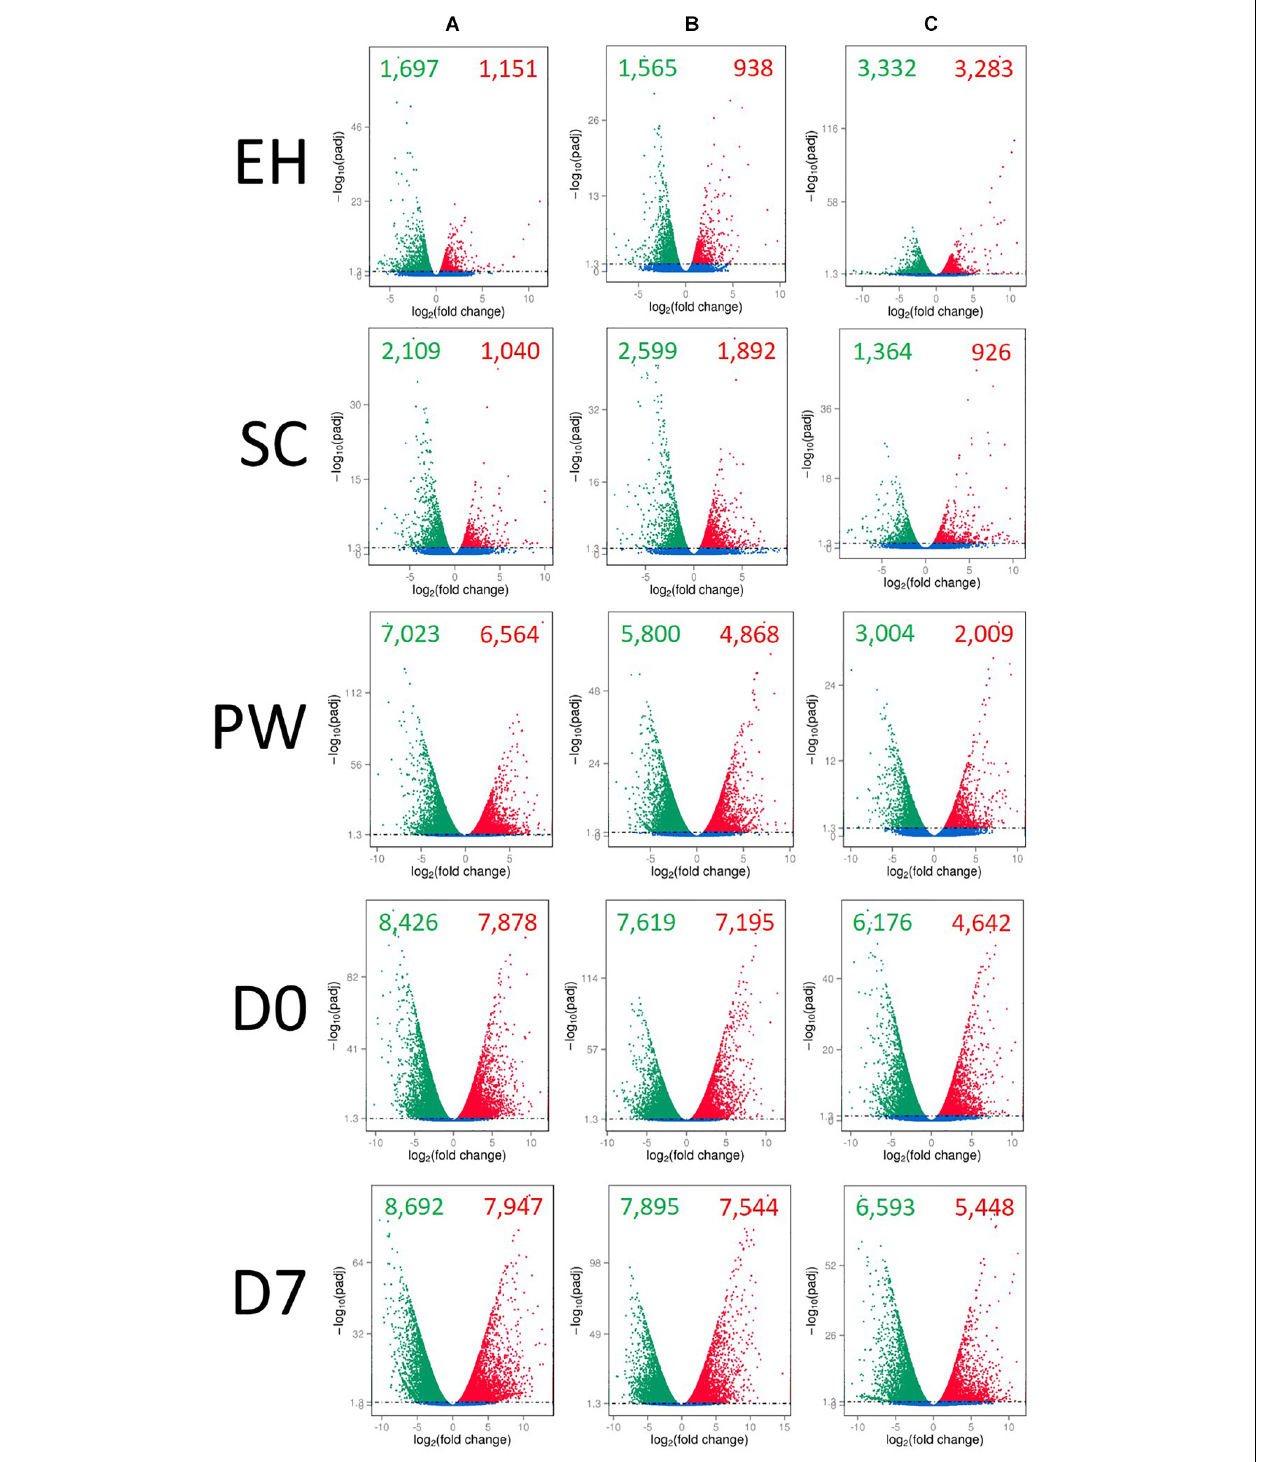
FIGURE 3 | Global differential gene expression and distribution in three elite inbred lines of Eruca sativa ( A–C ) across five time points, relative to harvest ( H ) samples for each line. Individual volcano plots display the log2-fold change of gene expression on the x -axis, and the degree of statistical significance on the y -axis ( q -value < 0.05, with removal of variations between biological replicates). Red dots, significantly up-regulated genes (relative to H ); green dots, significantly down-regulated genes (relative to H ); blue dots, no significant change in expression. EH , early harvest; SC , second harvest; PW , pre-wash; D0 , post-wash; and D7 , 7-day shelf